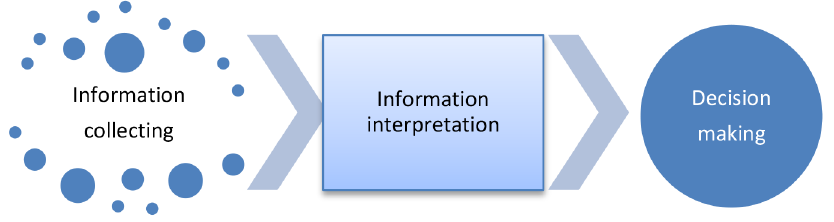
Figure 1. Three steps of interpretation